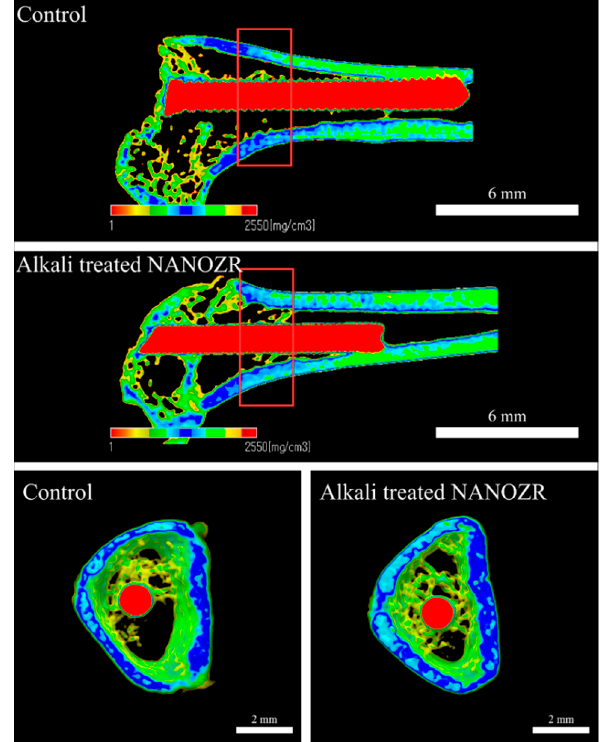
Figure 4. Micro-CT images (the implants are marked with red, cortical bone with blue, and cancellous bone with green).